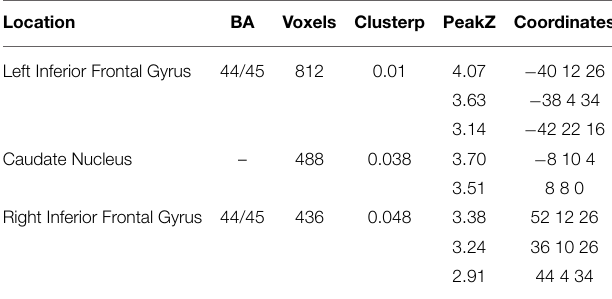
TABLE 2 | Regions activated by a linear effect of